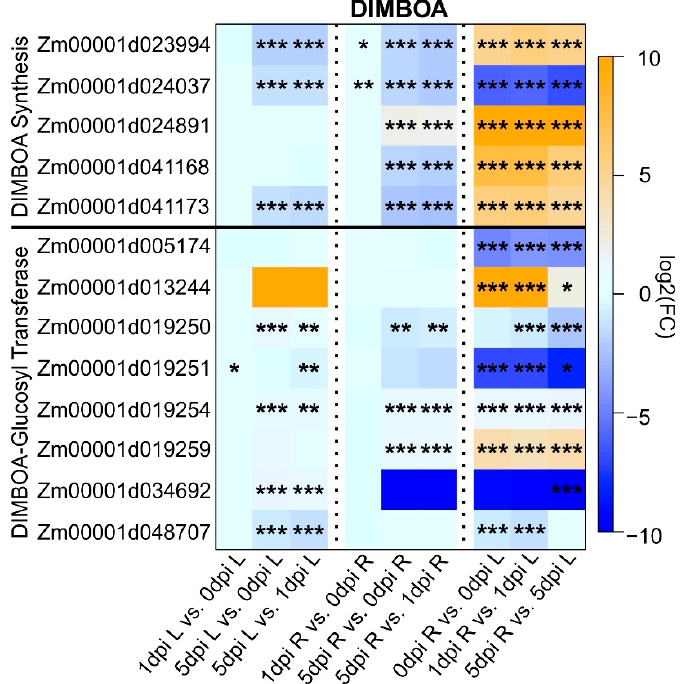
Figure 6. Heatmap of differentially expressed genes (DEGs) associated with DIMBOA biosynthesis pathway in maize. Each column corresponds to a condition for each tissue (L: leaves or R: roots). Each cell contains the corresponding log 2 (fold-change (FC Infested/Uninfested); genes upregulated are indicated in orange and downregulated in blue) and adjusted p value (*** < 0.001, 0.001 < ** < 0.01, 0.01 < * < 0.05). Maize gene IDs for the DIMBOA pathway were obtained from the